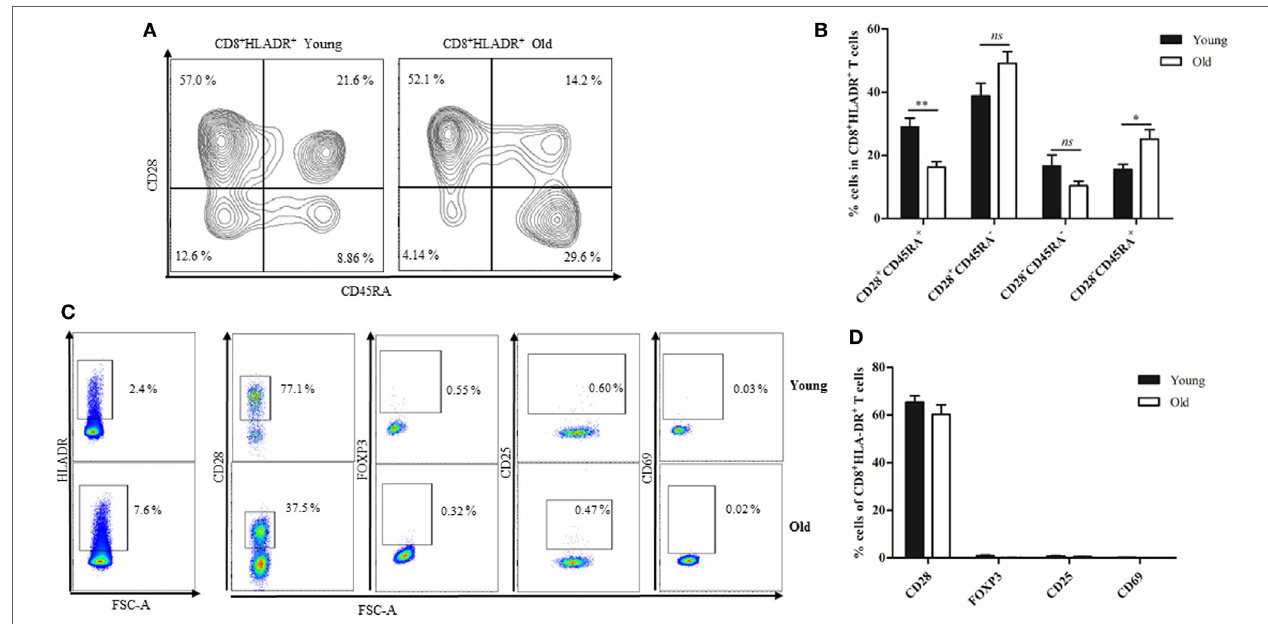
FigUre 6 | Phenotypical characterization of CD8 + human leukocyte antigen–antigen D related (HLADR) + T cells from young and old donors. (a) Representative FACS plots demonstrating the expression of CD45RA and CD28 in CD8 + HLADR + cells from a young and an old donor. (b) Expression of CD45RA and CD28 in CD8 + HLADR + cells from young and old donors, CD28 + CD45RA + , CD28 + CD45RA − , CD28 − CD45RA − , CD28 − CD45RA + cells are shown, young donors n = 18–21 ( < 30 years) and old donors n = 18–21 ( ≥ 70 years), mean ± SEM, ** p < 0.001, * p < 0.05, ns, not significant. (c) Representative FACS plots of activation markers and other molecules in CD8 + HLADR + T cells from a young (upper panel) and an old donor (lower panel). (D) Percentages of CD28, FOXP3, CD25, and CD69 cells in the CD8 + HLADR + population from young and old donors, young n = 18–21 ( < 30 years) and old donors n = 18–21 ( ≥ 70 years), mean ±